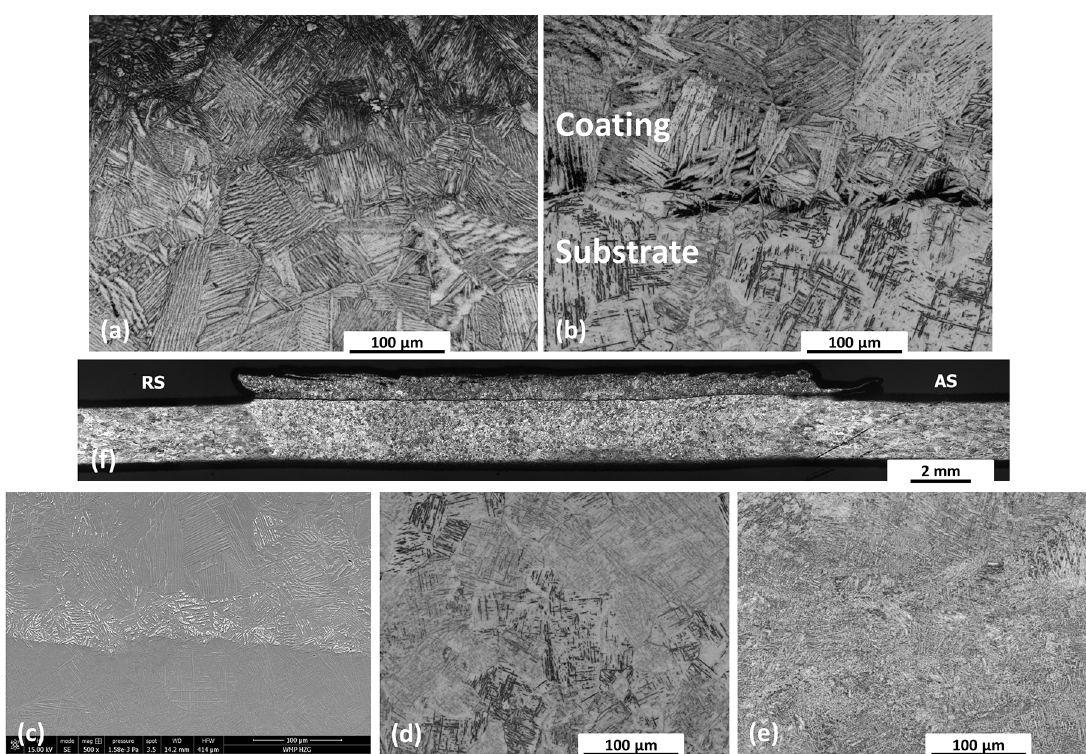
Figure 7. Gradual microstructure transformations on the (a) coating, (b) interface, (c) interface obtained by SEM, (d) substrate heat affected zone, (e) substrate base material and (f) cross section macrograph of the coating (4000